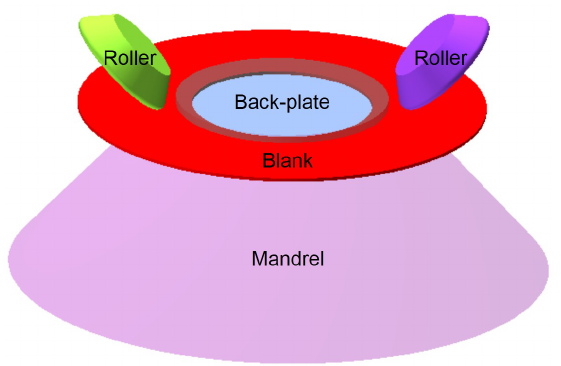
Figure 6. The finite element model of spinning.